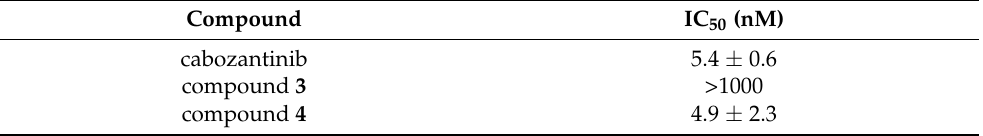
Table 1. IC 50 values against c -Met kinase a